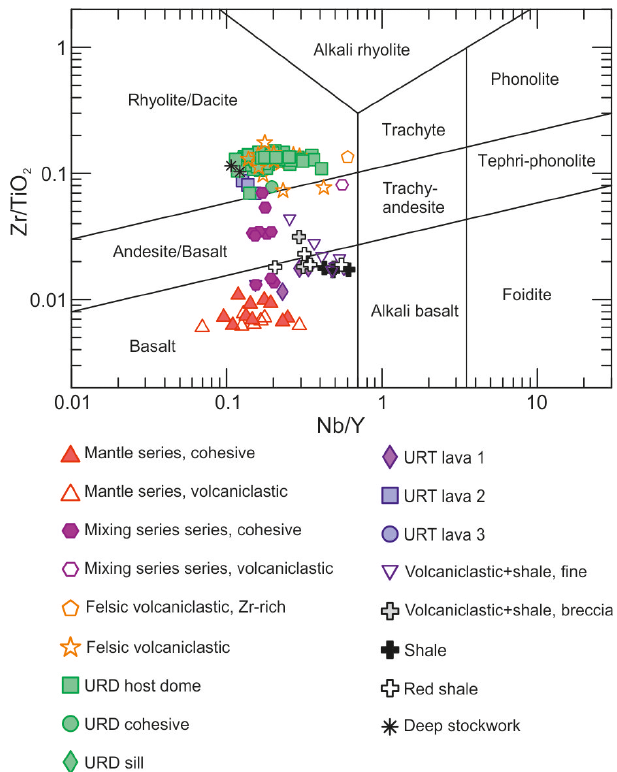
Figure 9. Zr / TiO 2 vs. Nb / Y diagram (Pearce, 1996, after Winch- ester and Floyd, 1977). Ratios are calculated using concentrations in micrograms per gram (µgg − 1